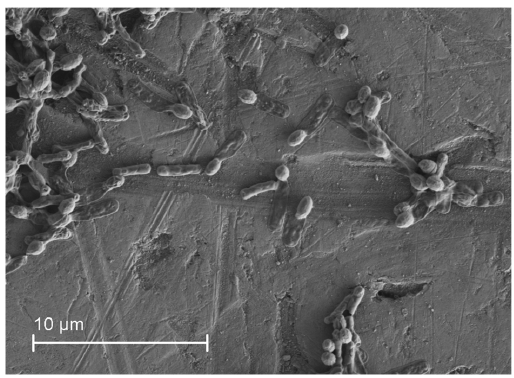
Figure 2. SEM image of Geobacillus sp. strain DUSELR13 during the late stationary phase. The majority of the cells show appear as flaccid with the presence of the terminal endospores.